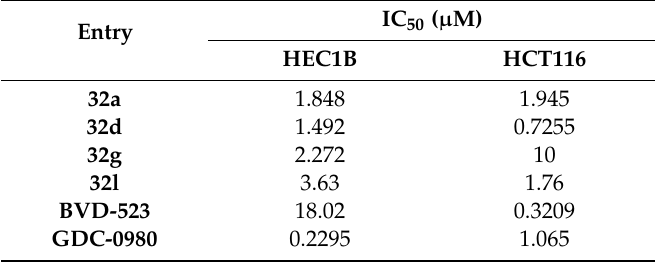
Table 6. In vitro anti-proliferation activities of selected compounds.